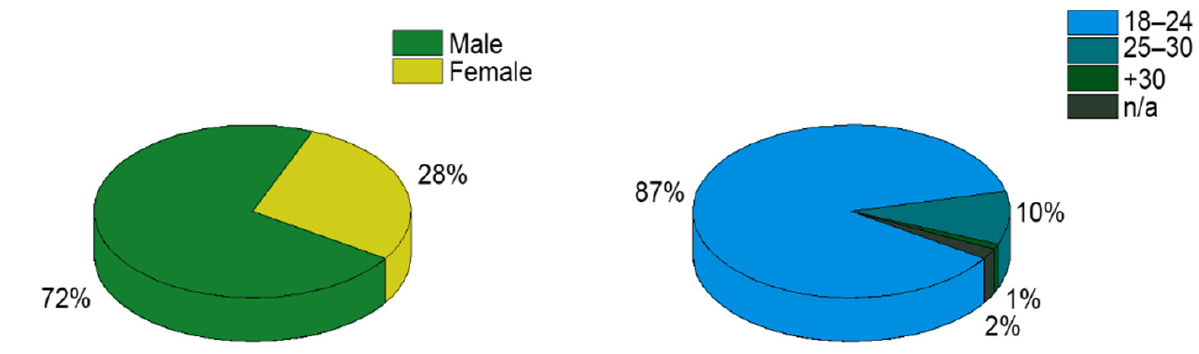
Figure 4. Gender and age of the surveyed students. Regarding the participants’ characteristics, 87% were aged between 18 and 24, a figure that rose to 97% when participants aged between 25 and 30 were included. The results obtained from the sensor monitoring are summarised in Table 4. Table 4. Results obtained from the field measurements during heating season (HS) and non-heating season (NHS).